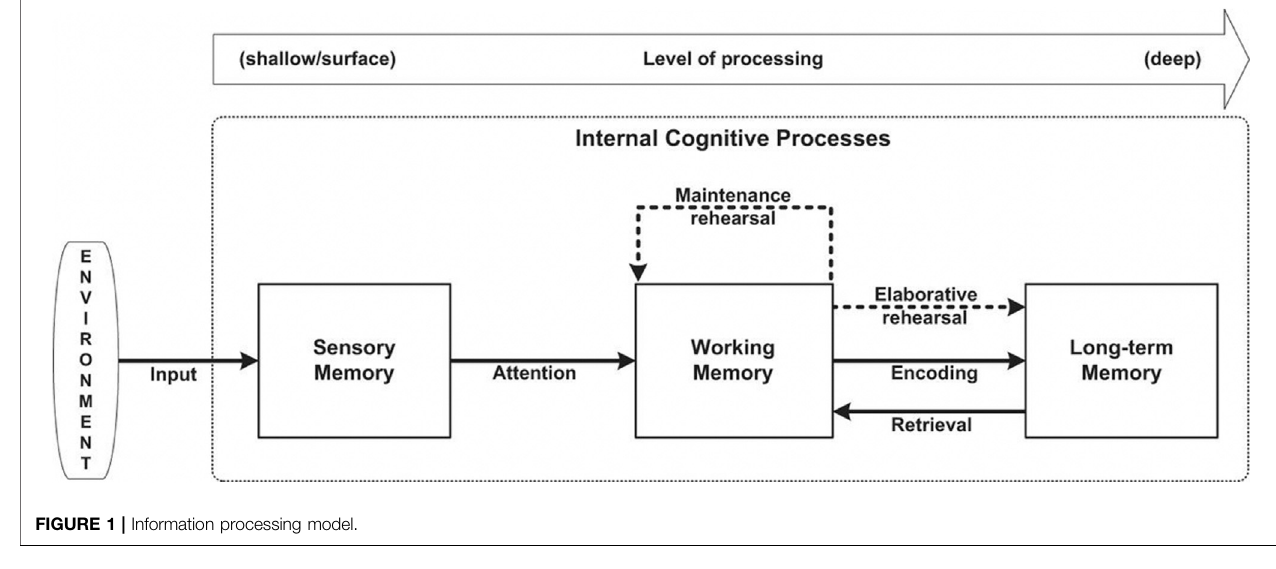
FIGURE 1 | Information processing model.